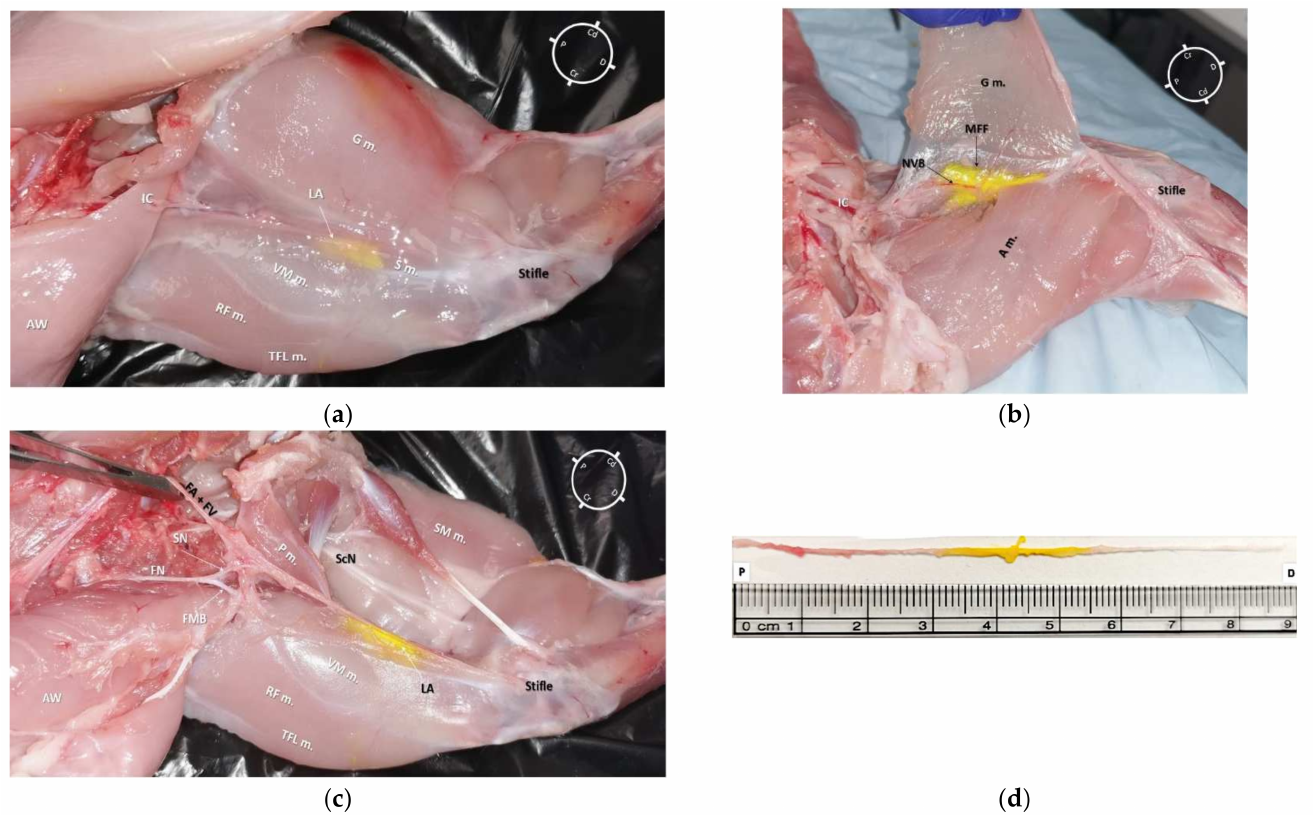
Figure 6. ( a ) Medial view of the right hind-limb of a rabbit cadaver in which a low volume dye solution (0.05 mL/kg, permanent yellow tissue dye solution and lidocaine 2% (1:50)) was injected. It is possible to observe the underlying tissues stained by dye solution in the central portion of the medial aspect of the thigh. ( b ) Medial view of the left hind-limb (different rabbit than ( a )) of a rabbit cadaver after partial dissection of the gracilis muscle. It was possible to observe the distribution of dye solution inside the medial femoral fascia (MFF), which contains the saphenous nerve (SN) and both the femoral artery (FA) and vein (FV). ( c ) Anatomical dissection of the medial aspect of a left hind-limb. The gracilis, sartorius, and adductor magnus muscles were bluntly removed. It was possible to observe the dye solution within the medial femoral fascia staining the neurovascular bundle (SN, FA, and FV); the dye solution did not stain the femoral nerve (FN) and its motor nerve branches (FMB). It was possible to localize the pectineus muscle insertion onto the surface of the femur at the level of the first third of the thigh, which was caudal and lateral in relation to the SN. ( d ) The SN was completely removed from the cadaver (from where it branched off the FN to the proximal stifle, where it deepened to innervate the articular capsule) for the evaluation of its total length (9 cm) and extent of staining from the tissue dye solution (1.9 cm). S m.: Sartorius